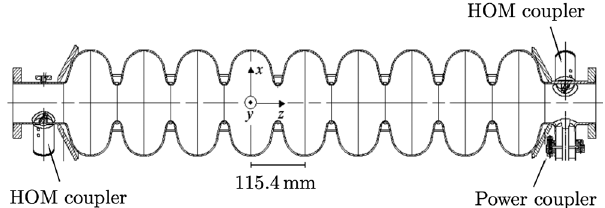
FIG. 2. Longitudinal cross section of a TESLA cavity. The beam direction is from left to right, thus the fundamental power coupler is located at the downstream end of the